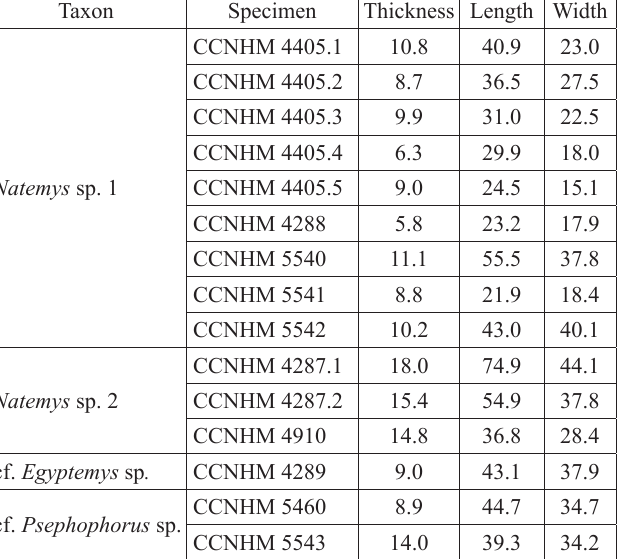
Table 1. Size dimensions (in mm) of leatherback sea turtle ossicles from the Ashley and Chandler Bridge formations, Charleston,